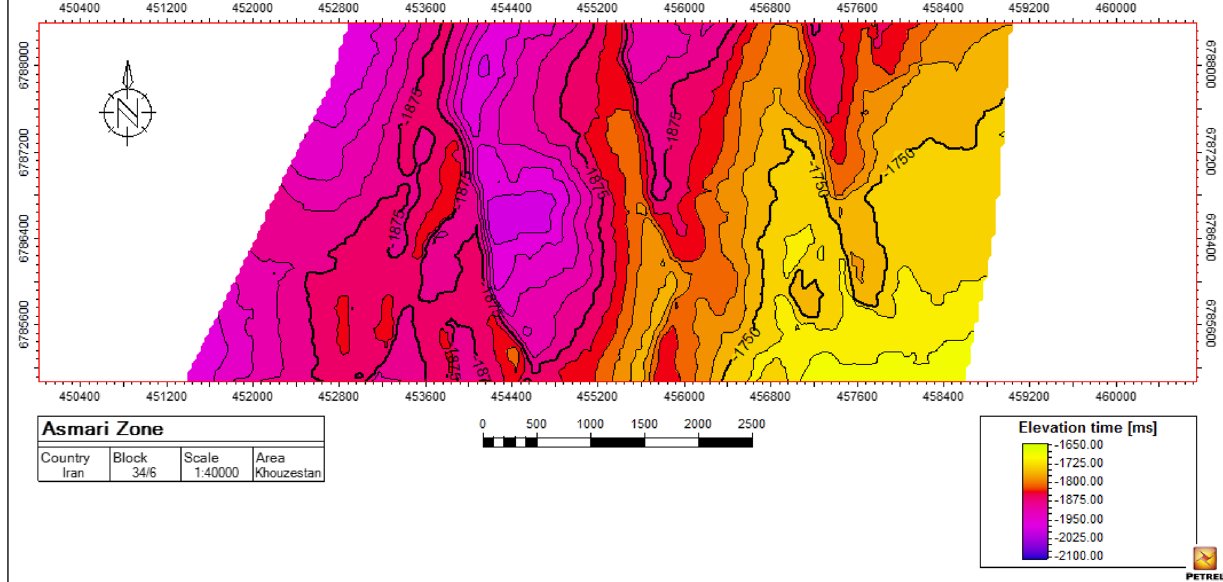
Fig. 3 One of the seismic sections of the Asmari and Bangestan horizon data in the field of study over a range of 1800–2300 ms